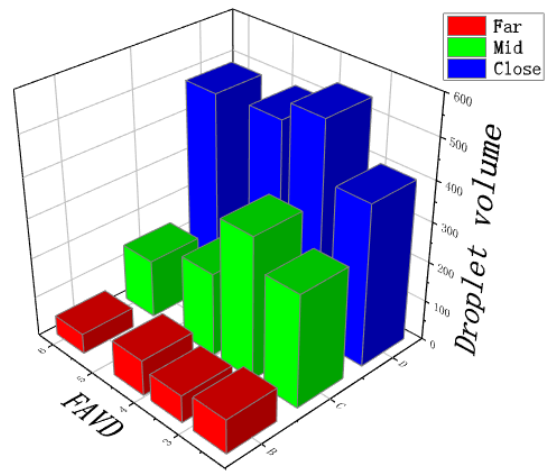
Figure 13. The canopy droplet deposition retention under different airflow velocity.